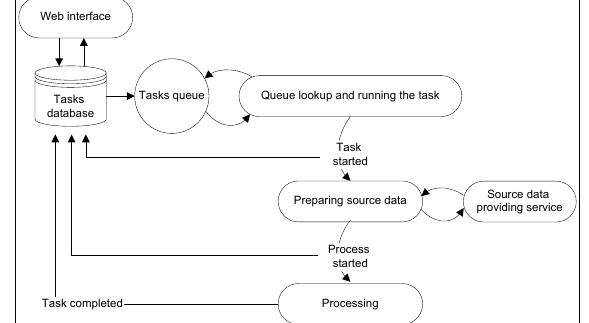
Figure 6. Life cycle of processing request.